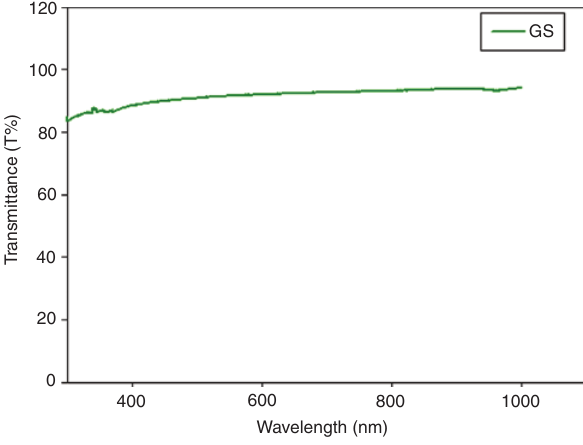
Figure 5: Electrical conductivity graph for GS zinc oxide nanoparti- cles (ZnO-NPs) sample.